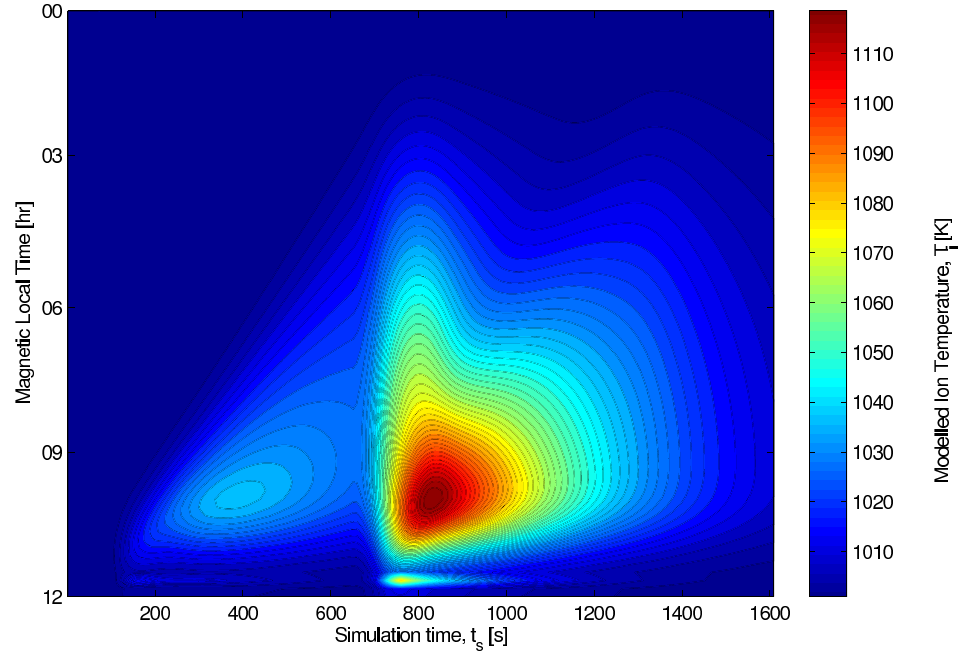
Fig. 7. Same as Fig.5, but for a reconnection pulse separation of 10min. Note the change in the ion temperature scale used compared to Fig. 5 because lower temperatures are driven by the second pulse; this results from the greater separation between pulses allowing the remnant flow to decay